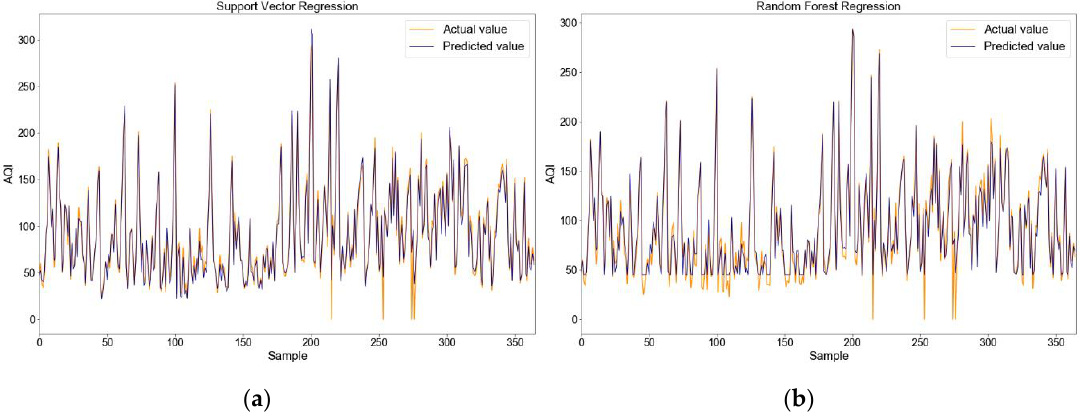
Figure 4. Scatterplots of the actual values and the predicted values: ( a ) SVR model, ( b ) RFR model.